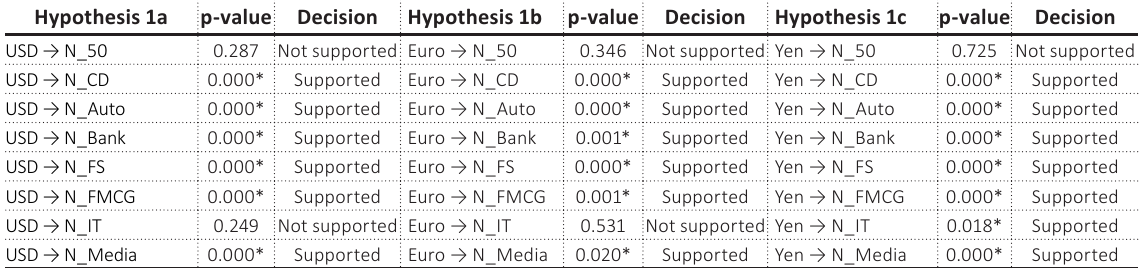
Table 4. Summary of hypothesis testing